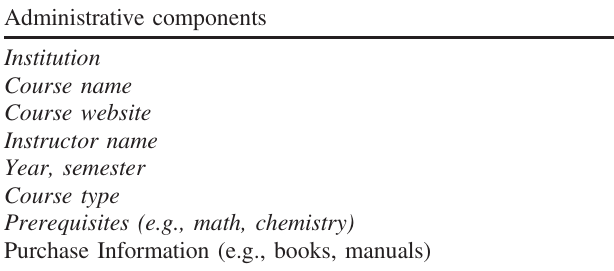
TABLE XII. Summary of the syllabi components. Italicized descriptors indicate key syllabi components identified in most of the IPLS syllabi analyzed ( N ¼ 77 ). The remaining components were identified using the interviews and the focus group described in Secs. III and